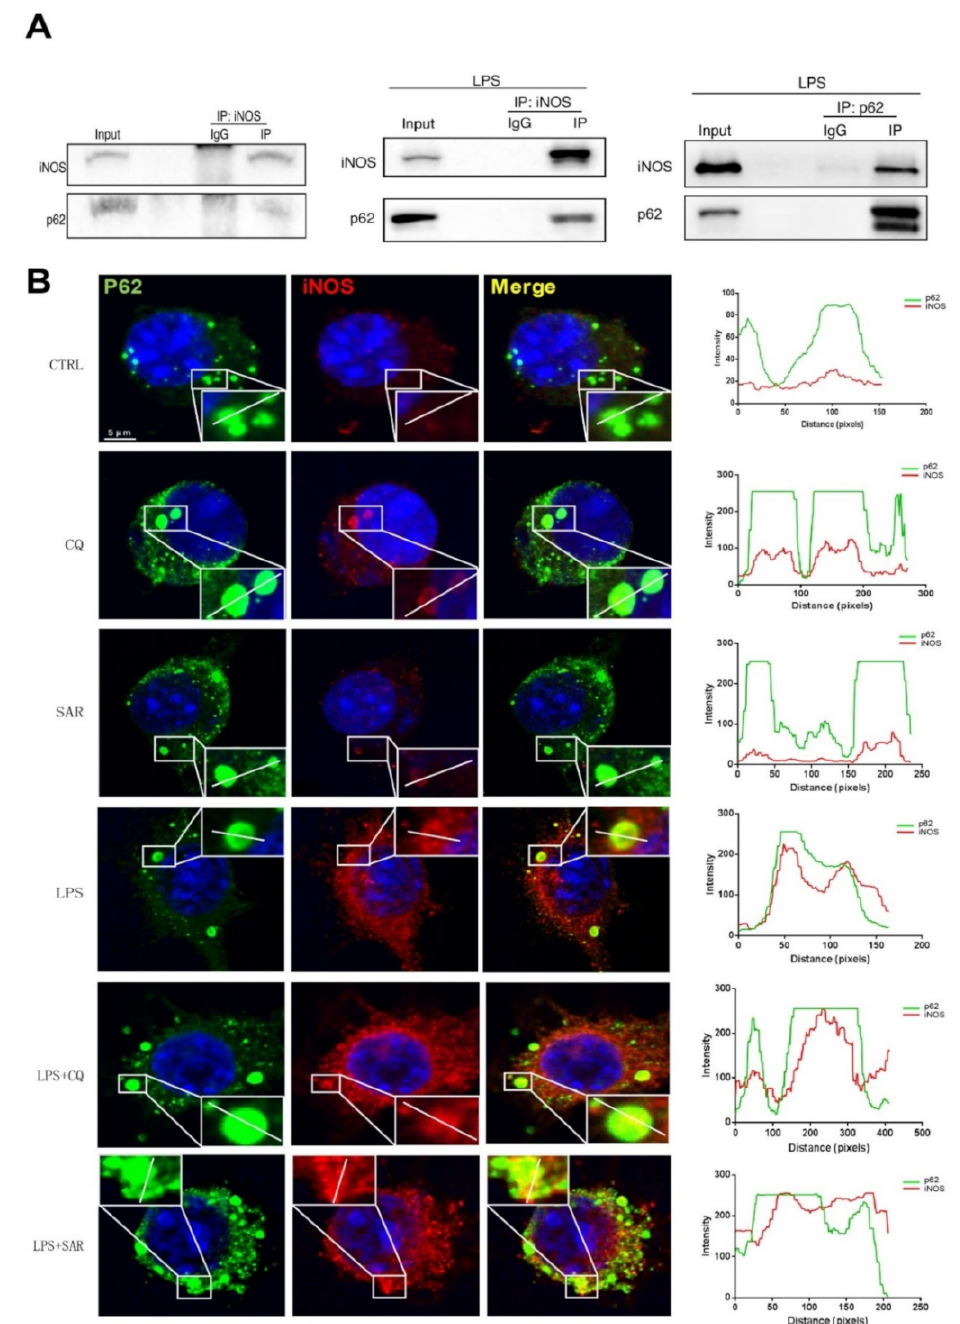
Figure 3. iNOS interacts and co-localizes with p62. ( A ) Raw 264.7 cells were treated with non-vehicle or LPS for 12 h. The co-immunoprecipitation analysis of protein extracts from Raw 264.7 expressing iNOS, p62. ( B ) Raw 264.7 cells were treated with CQ (30 µ M) and SAR (1 µ M) for 12 h. CTRL group is blank control group with DMSO treatment. The confocal analysis showed the interaction between p62 and iNOS under CQ and SAR treatment. Raw 264.7 cells were treated with LPS (1 µ g / mL) 12 h, followed by removing LPS and add CQ (30 µ M), SAR (1 µ M) for another 12 h. the confocal images of Raw 264.7 cells which were stained with anti-iNOS and anti-p62 were captured by Leica microsystems. The results of co-localization were analyzed by Leica Application Suite X software and GraphPad